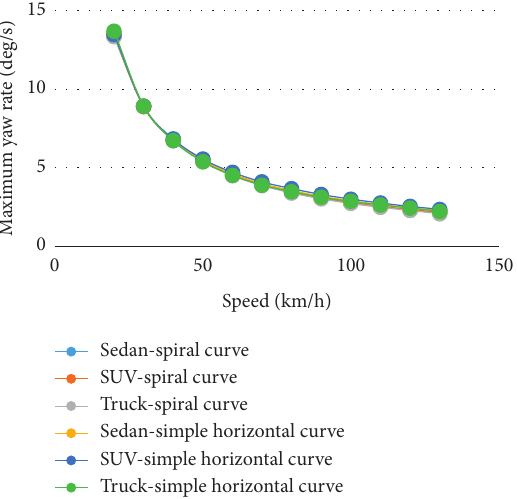
Figure 23: Maximum yaw rate in the simple and spiral horizontal curves versus the speed at radius R